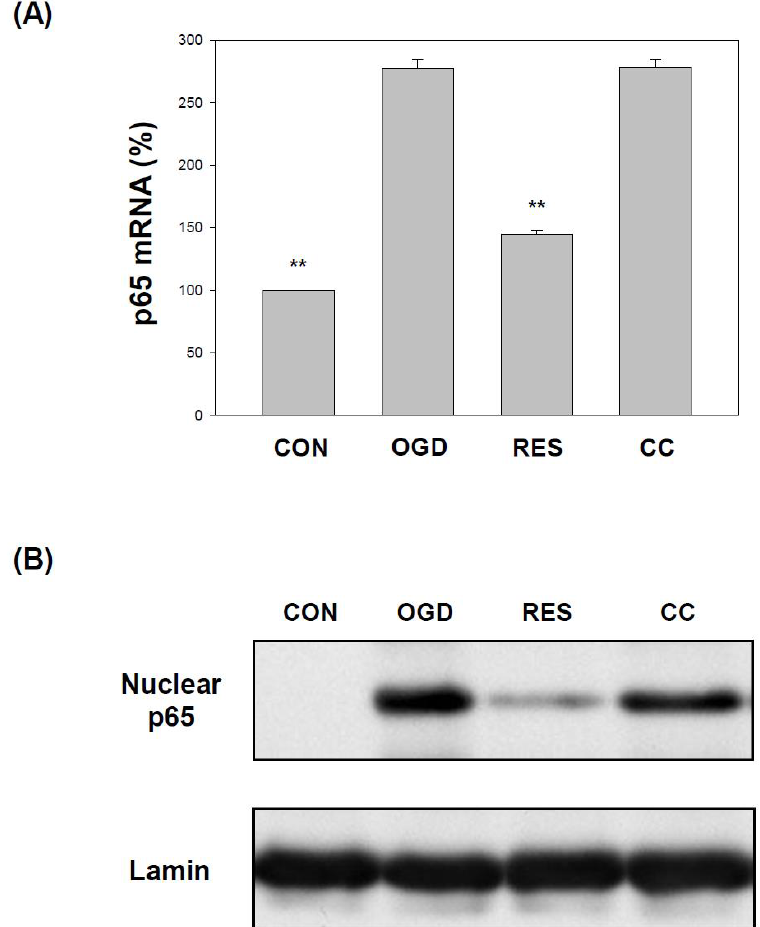
Figure 3. Resveratrol normalizes p65 levels in the OGD-induced cells in the 3D scaffold. The cell experiments under the scaffolds were divided into four groups, as described in Figure 1 and the methods section. ( A ) qPCR was used to analyze the p65 mRNA level in each treatment group. Collect total RNA from cells and reverse transcribe it into cDNA. Perform qPCR on the specified gene and normalize it to GAPDH expression. The value is expressed as a percentage of the transcript established in CON and the mean ± SEM value from three independent experiments. ( B ) Collect nuclear components (20 µ g per lane) from the specified conditions and perform the level of p65 protein by a Western blot analysis. The value is expressed as the percentage of SH-SY5Y cells treated with OGD and described as the mean ± SEM value from three independent experiments. Specific comparison to the indicated SH-SY5Y cells with OGD ** p < 0.001 vs. cells with